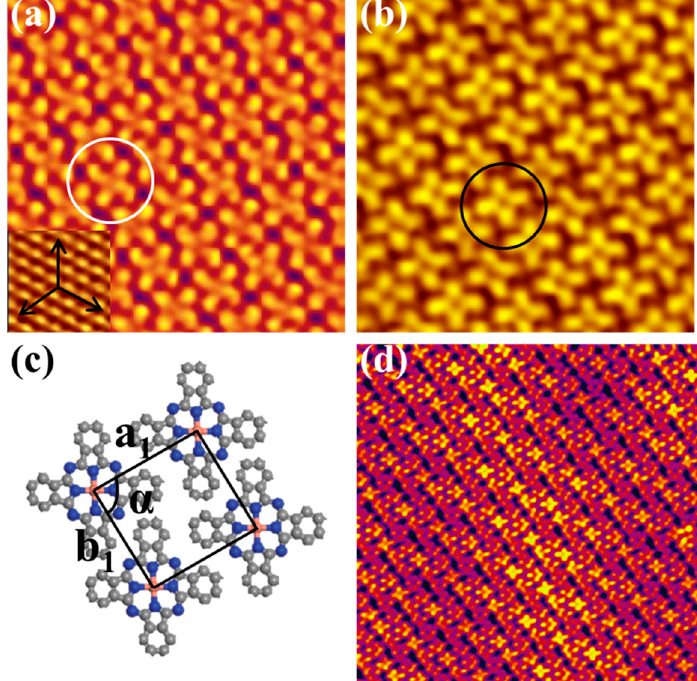
Figure 3. ( a ) Chiral feature appeared in the filled state STM image of the two-dimensional domains, 15 × 15 nm, − 1.4 V, 28 pA; ( b ) Chiral feature disappeared essentially in the empty state STM image of the 2D domains, 10 × 10 nm, +0.5 V, 28 pA; ( c ) The structural model of the flat-lying 2D domain; ( d ) Morié fringe observed in the 2D domain of CuPc, 30 × 30 nm, − 2.0 V, 28 pA.